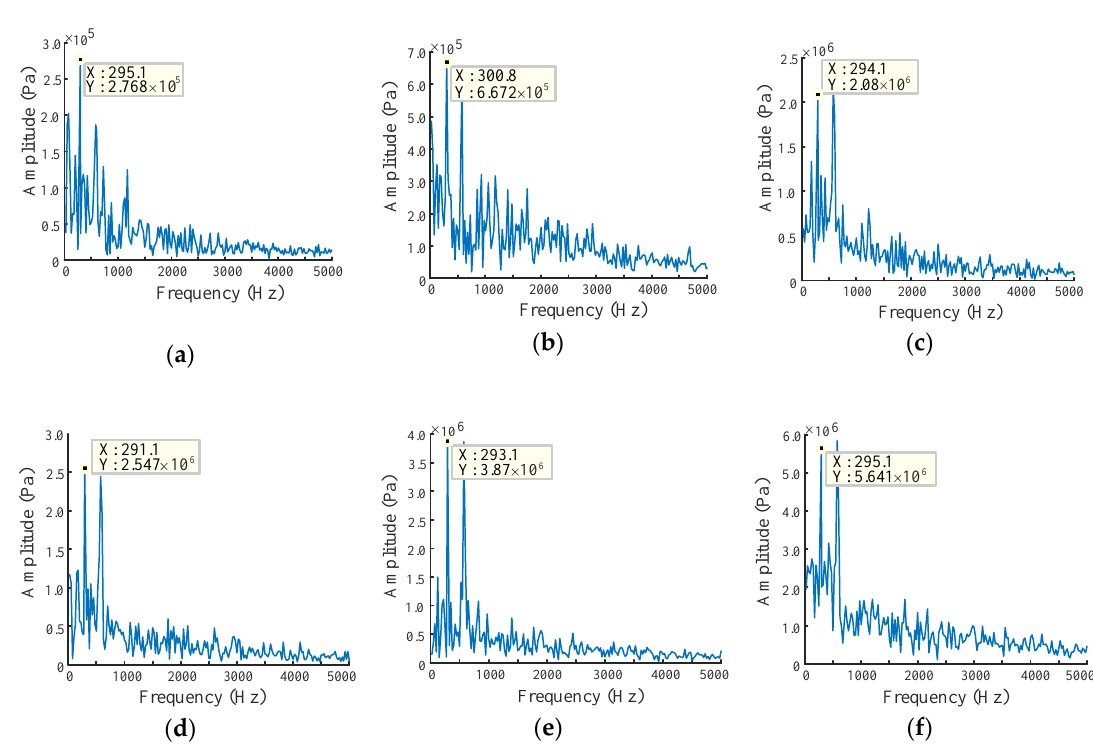
Figure 15. FFT of pressure signal under different end face wear gaps: ( a ) wear gap is 50 μm; ( b ) wear gap is 100 μm; ( c ) wear gap is 200 μm; ( d ) wear gap is 300 μm; ( e ) wear gap is 400 μm; ( f ) wear gap is 500 μm.